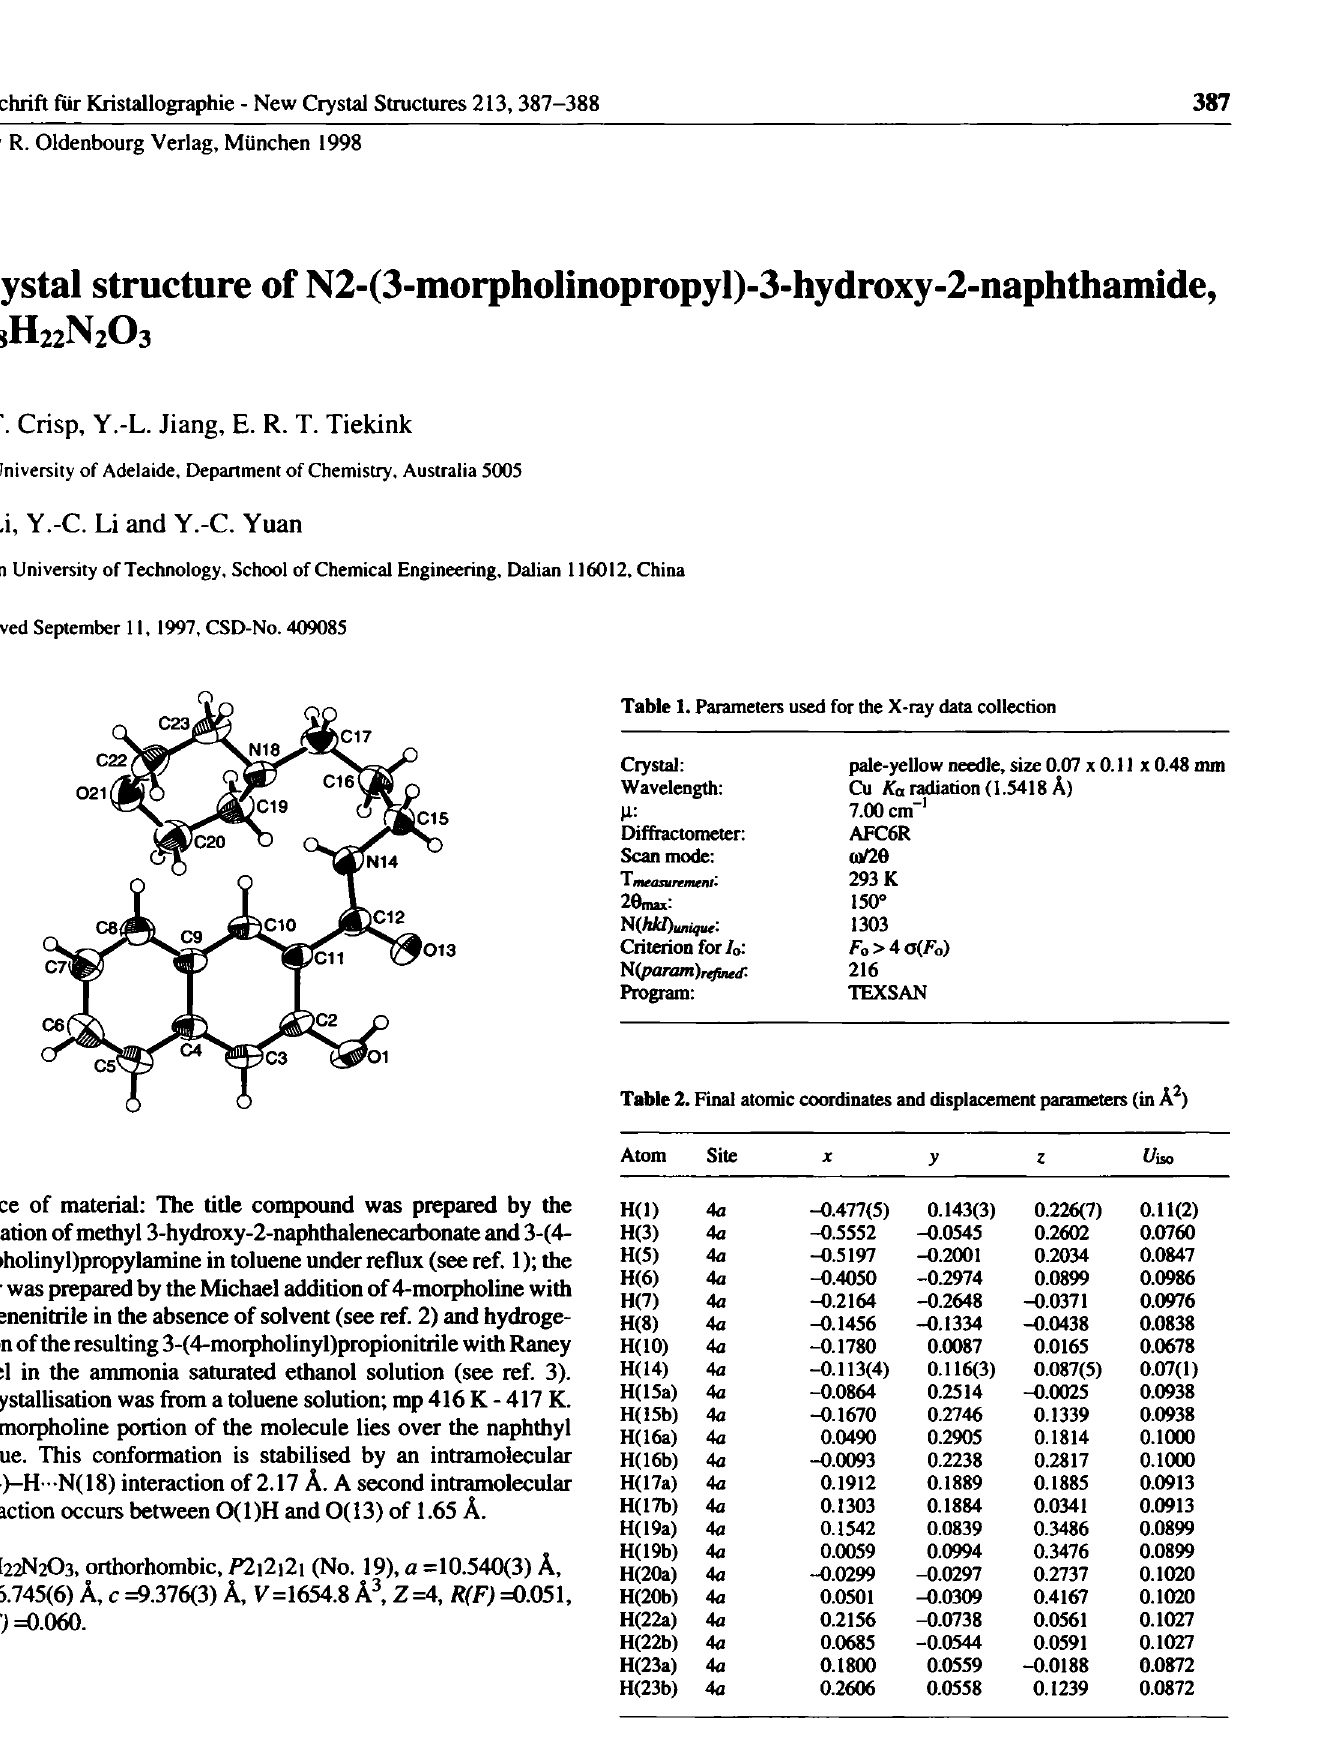
Table 3. Final atomic coordinates and displacement parameters (in Â^)